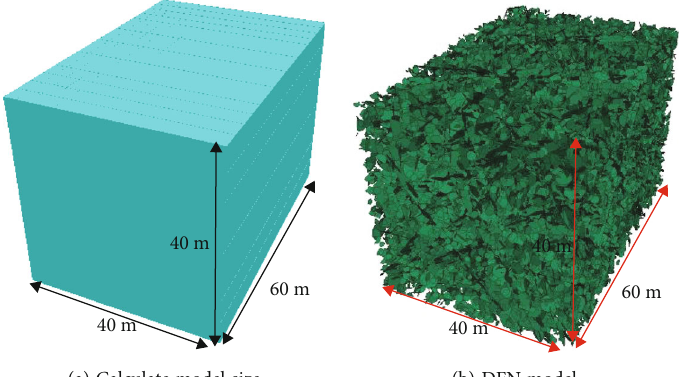
Figure 5: Numerical calculation discrete element model.